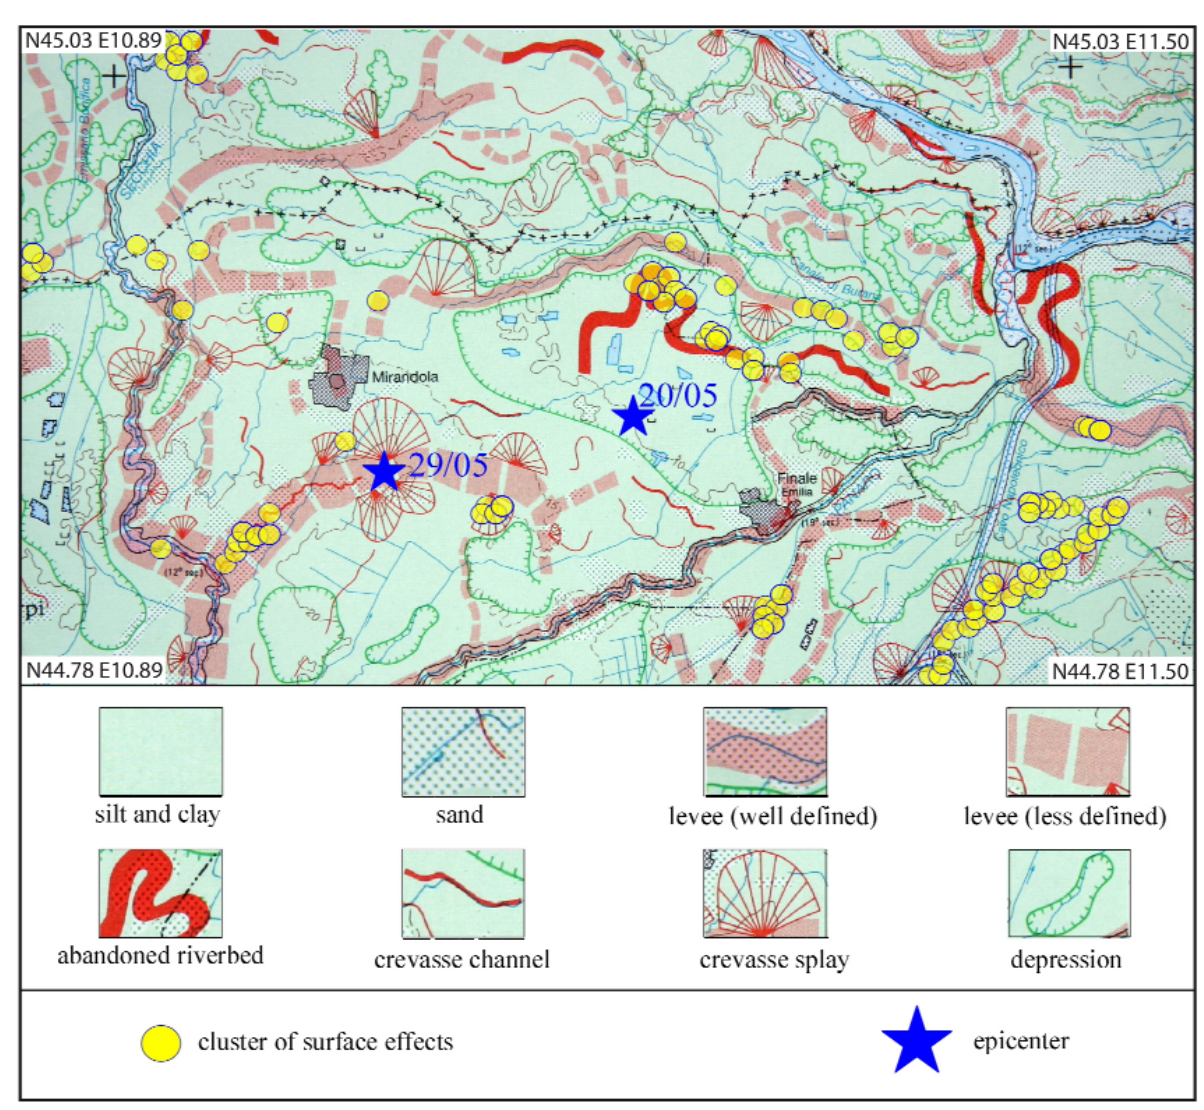
Figure 1. Sketch map of the surficial geological effects induced by the recent earthquakes, and their relationships with geomorphological features. Geo- morphological map from Castiglioni et al.